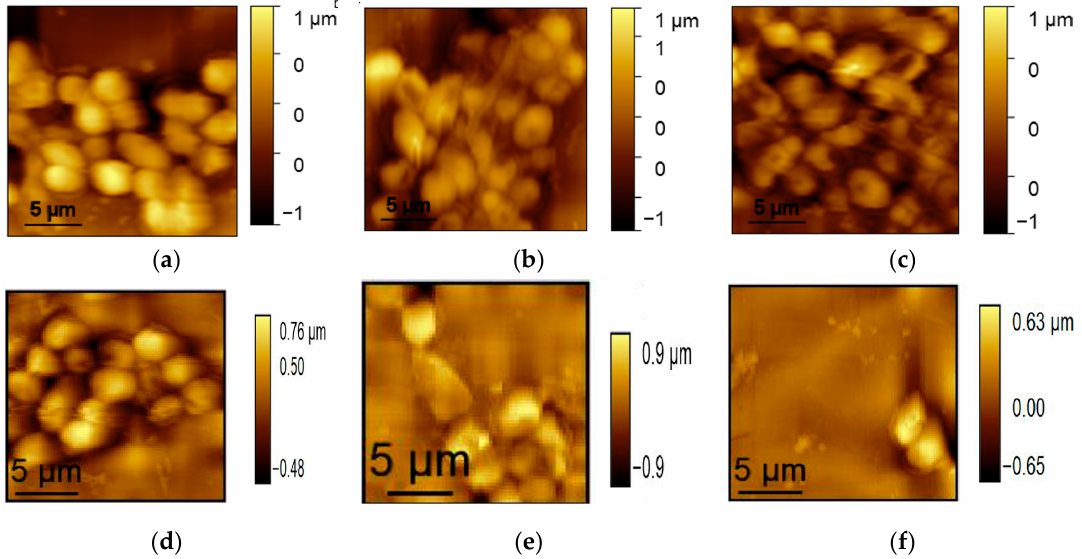
Figure 12. AFM surface topography of Candida albicans ATCC 10231 cell development on HAp ( a – c ) and 5SmHAp coatings ( d – f ) at different time intervals of incubation collected on an area of 20 × 20 µm 2 .